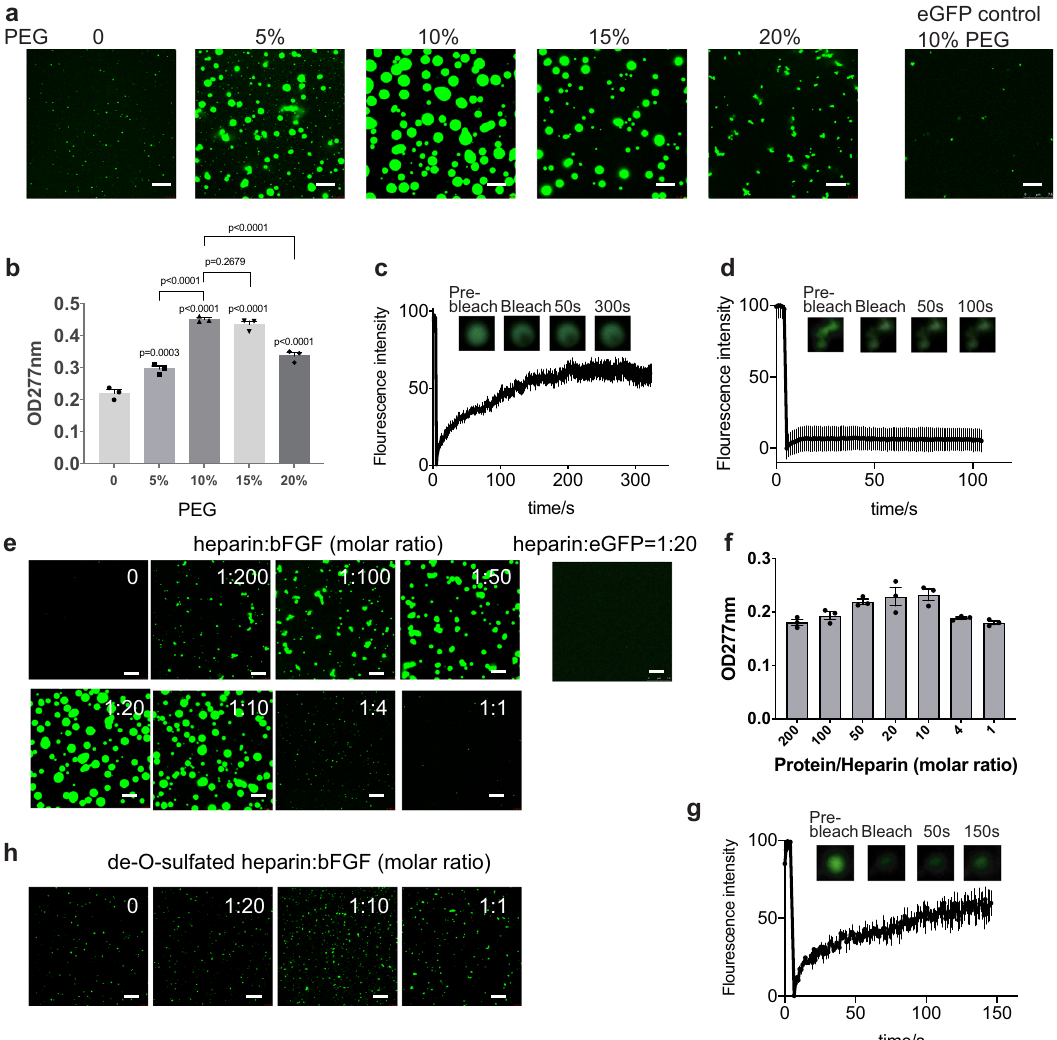
Fig. 1 bFGF undergoes phase separation in the presence of PEG or heparin. a Confocal microscopy images of assembling status of 5 μ M eGFP-bFGF with 0 – 20% PEG, with eGFP alone in 10% PEG as control. Scale bar = 5 µ m. b Turbidity measurement of eGFP-bFGF with 0 – 20% PEG. n = 3 biologically independent samples, data are presented as mean values ± SEM. Comparisons among groups were performed using ordinary one-way ANOVA test. c , FRAP of the droplets formed by eGFP-bFGF with 10% PEG. n = 5 biologically independent samples, data are presented as mean values± SEM. d FRAP of the aggregates formed by eGFP-bFGF with 20% PEG. n = 3 biologically independent samples, data are presented as mean values ± SEM. e Confocal microscopy images of assembling status of 5 µ M eGFP-bFGF mixed with heparin at different ratios, with heparin: eGFP = 1:20 as control. Scale bar = 5 µ m. f Turbidity measurement of eGFP-bFGF with heparin. n = 3 biologically independent samples, data are presented as mean values± SEM. g FRAP results of the droplets formed by heparin:eGFP-bFGF = 1:20. n = 3 biologically independent samples, data are presented as mean values± SEM. h Confocal microscopy images of assembling status of 5 uM eGFP-bFGF mixed with de-O-sulphated heparin at different ratios. Scale bar = 5 µ a de-O-sulphated heparin (OD-heparin) 32 . Addition of the OD- heparin failed to induce LLPS of bFGF (Fig. 1h). This indicates multivalent interactions between the protein and highly nega-